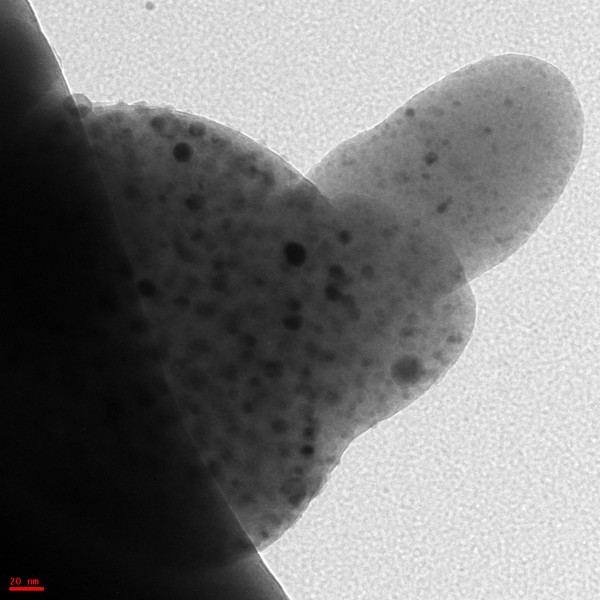
Apollo 14 lunar dust image. A scanning electron micrograph image of authentic lunar dust with iron metal inclusions.